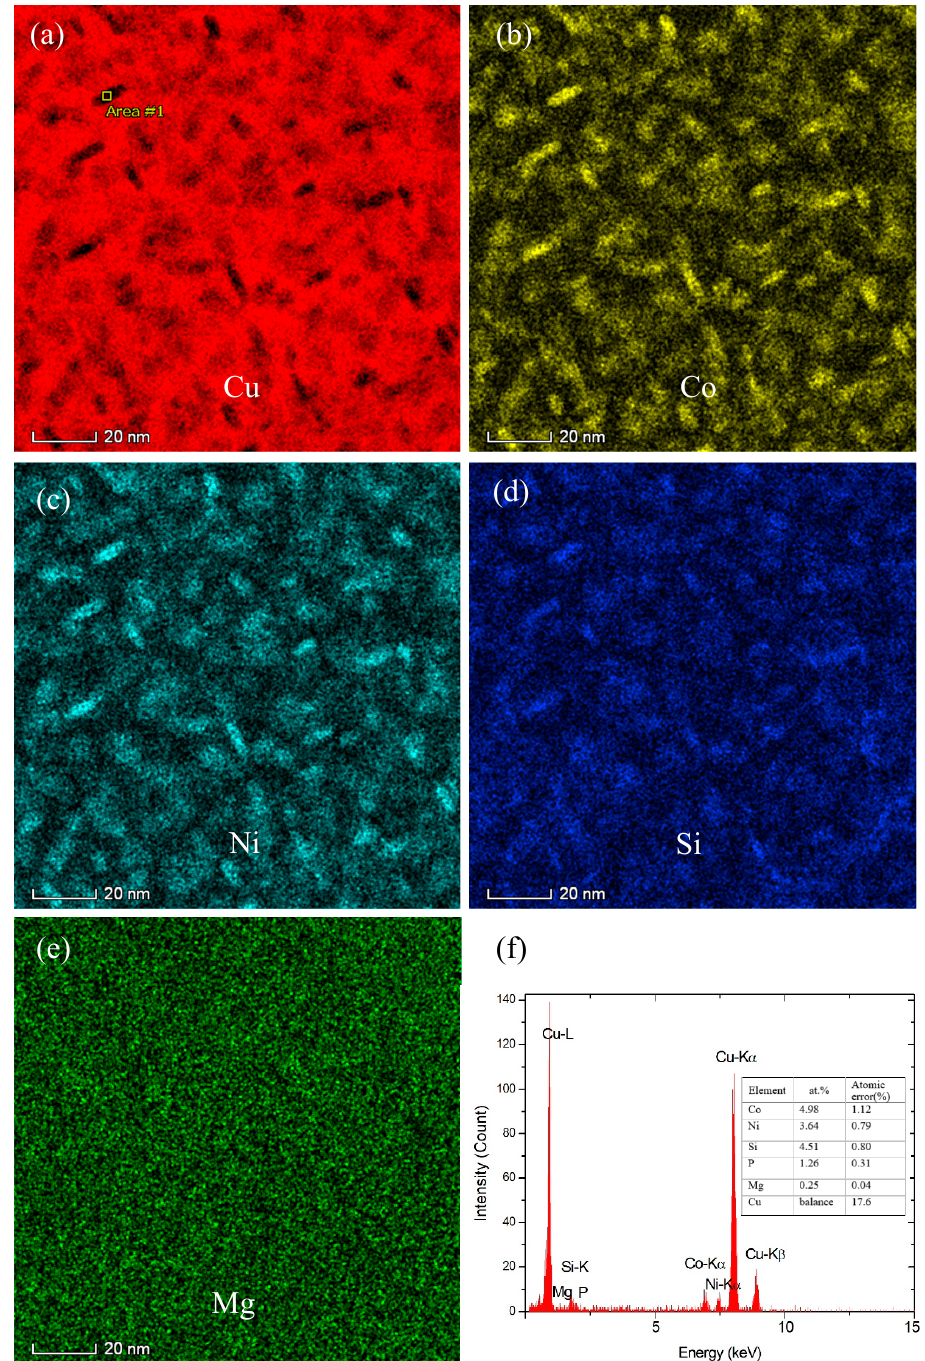
Figure 5. STEM elemental mapping images of the C4 alloy aged at 500 °C for 4 h. ( a ) Cu, ( b ) Co, ( c ) Ni, ( d ) Si, ( e ) Mg, ( f ) EDS result of a precipitate particle (labeled by “Area #1” in ( a ).